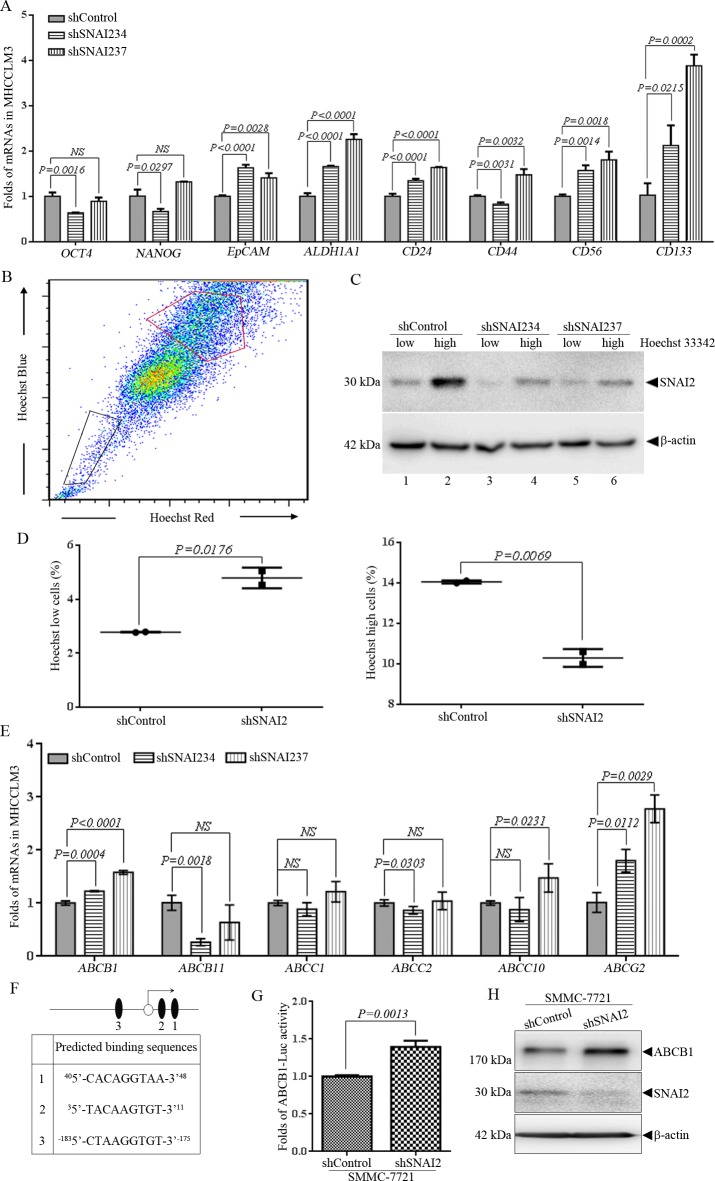
SNAI2 knockdown promotes the efflux of Hoechst 33342 and increases ATP binding cassette (ABC) transporter and CSC gene expression of MHCCLM3 cells.(A) Q-PCR was applied to detect mRNA levels of indicated genes in MHCCLM3 cells expressing shSNAI2/shControl shRNAs. Relative expression of indicated genes was normalized with GAPDH mRNA. (B-D) FACS was utilized to sorting cell populations of MHCCLM3 cells expressing shControl or shSNAI2 with low (black frame) and high (red frame) Hoechst 33342 staining (B), followed by Western blot for SNAI2 expression (C). Percentage of Hoechst low or high cell population was shown and compared (D). (E) Q-PCR was applied to detect mRNA levels of ABC transporter genes in MHCCLM3 cells expressing shSNAI2/shControl. Relative expression of ABC transporter genes was normalized with GAPDH mRNA. All values were represented as mean with bar as SD of three independent experiments, and the P values were measured between two linked groups. All experiments were repeated at least three times with similar results. (F) A diagram of the promoter of ABCB1 gene that drives luciferase reporter plasmid pGL3-ABCB1-luc. Empty circle and black ovals represent the transcriptional start point of ABCB1 gene and predicated binding sites of SNAI2 respectively. Sequences of predicated binding sites are shown in the text box below. (G) SMMC-7721 cells expressing shSNAI2 or shControl were transfected with luciferase reporter plasmid pGL3-ABCB1-luc and pRLSV40-Renilla. Luciferase Assay was conducted as described in Materials and Methods. (H) Western blot was applied to measure expression of indicated proteins in SMMC-7721 cells expressing shSNAI2 or shControl.